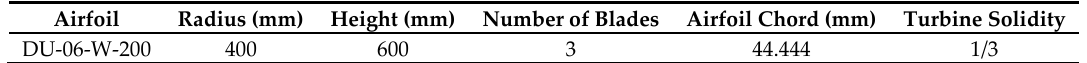
Table 1. Geometrical characteristics of the VAWT